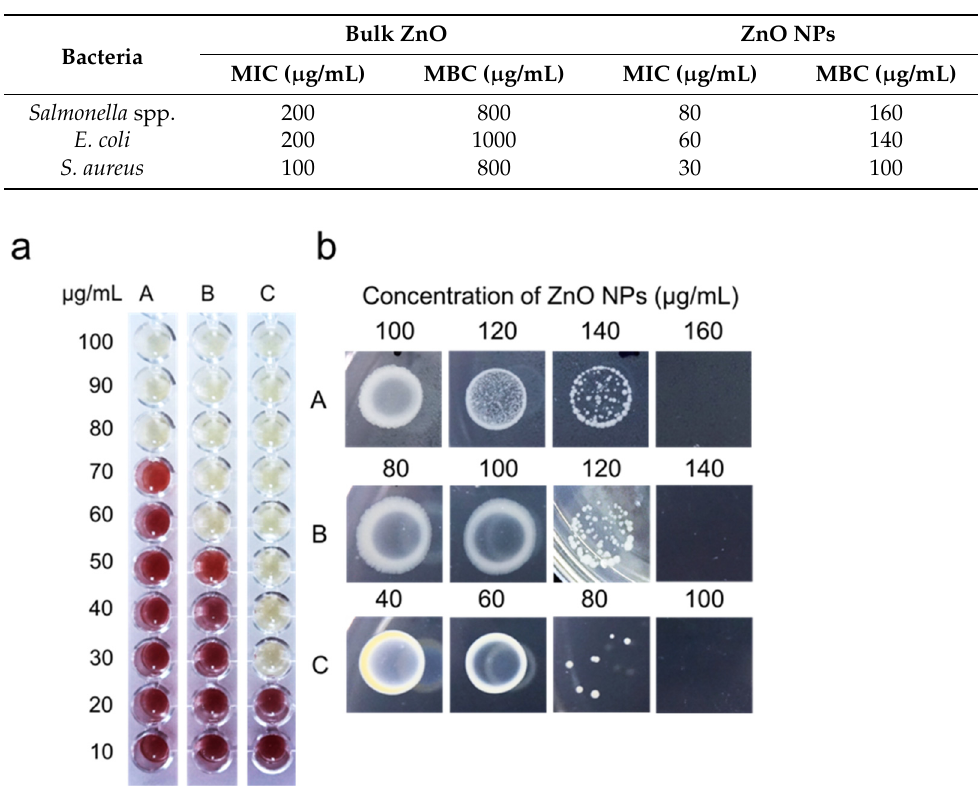
Figure 3. ( a ) Minimum inhibitory concentration (MIC) and ( b ) minimum bactericidal concentration (MBC) of biosynthesized ZnO NPs against ( A ) Salmonella spp., ( B ) E. coli, and ( C ) S. aureus.